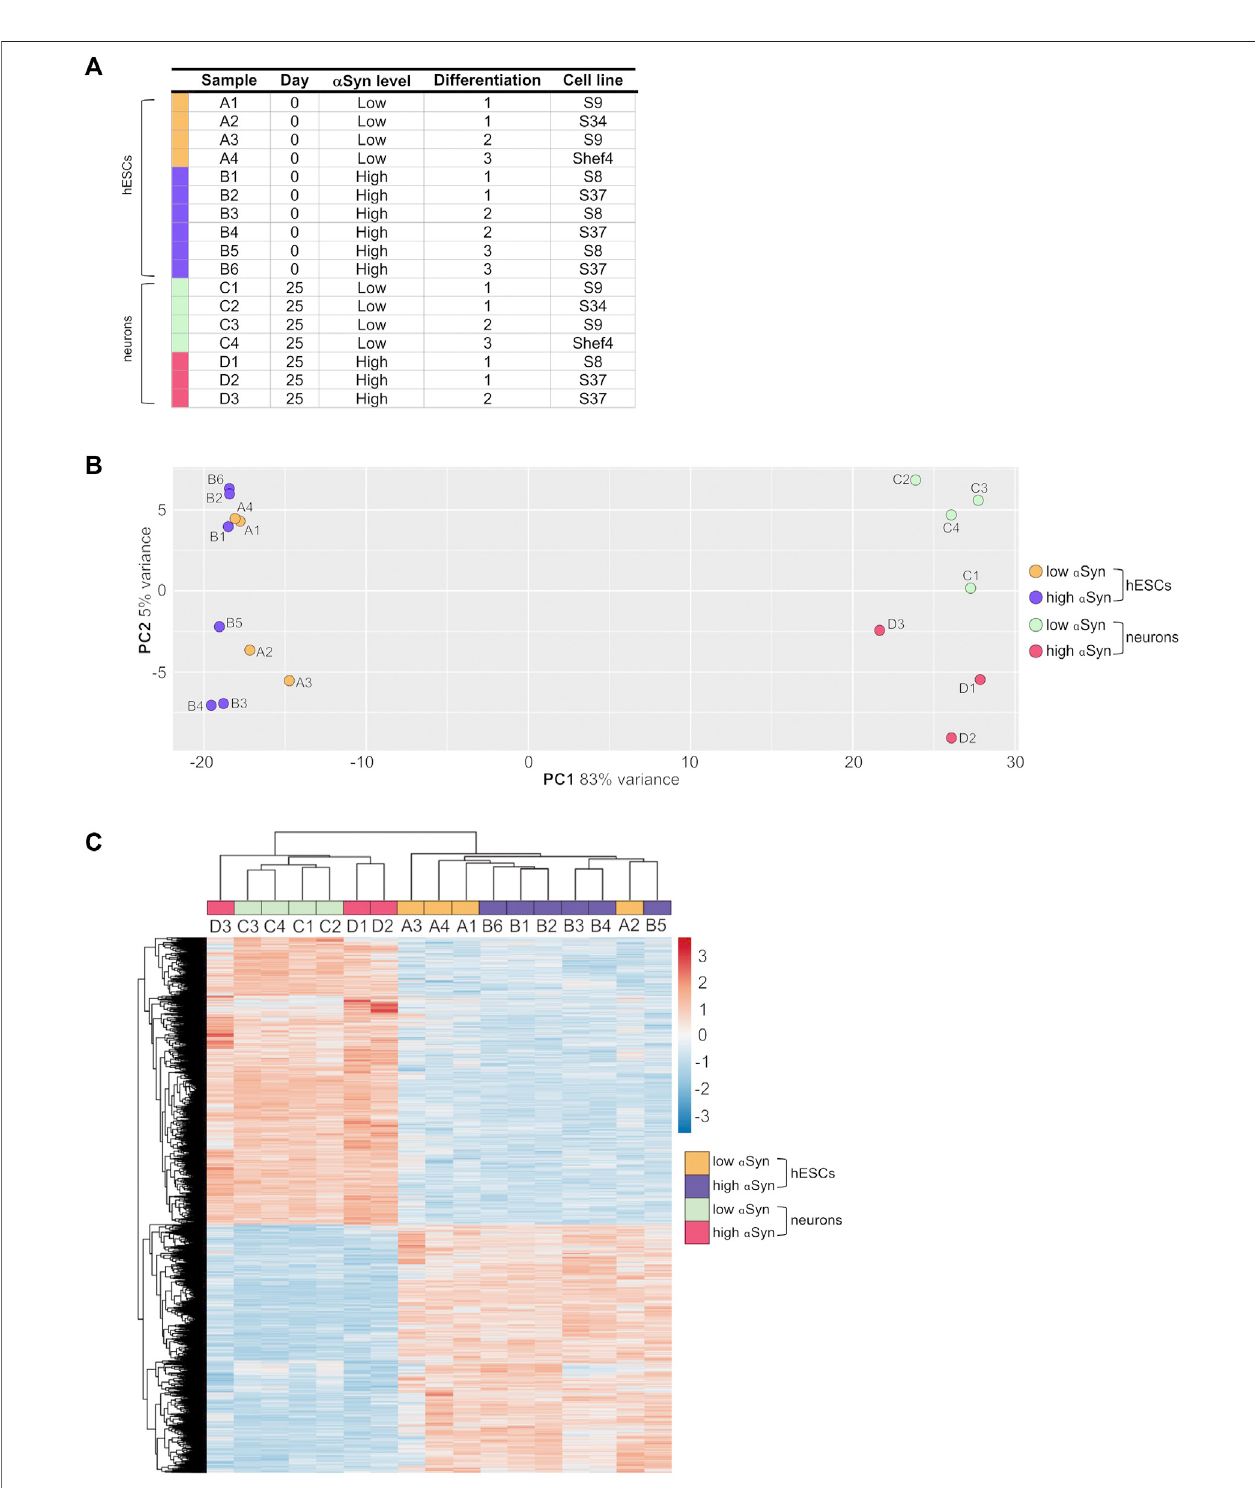
FIGURE5 | RNA-seq analysis ofclonal hESClines and differentiated cortical neurons. (A) Table of individual sample groups highlighting α Syn levels, differentiation experimentgroup,andthecelllineofsamples. N =3forhigh α Syncorticalneurons, N =4forbothlow α SynhESCsandcorticalneurons,and N =6forhigh α SynhESCs. (B) Principal component analysis (PCA) plot of all samples. (C) Heatmap of a hierarchical cluster analysis of differential expression results, showing relative gene expression changes as either upregulated (red) or downregulated (blue). Analysis was carried out with log 2 -transformed raw counts. Plot encompasses all differentially expressed genes from all four DESeq2 pairwise comparisons, representing 5,157 genes in total.